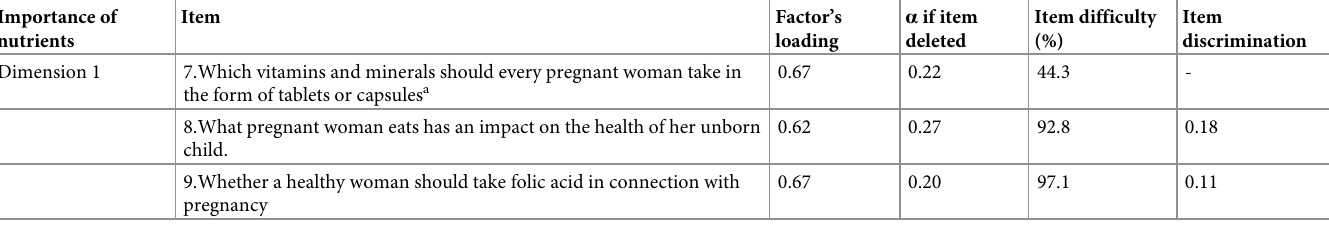
Table 5. Importance of nutrients domain: Factor analysis and reliability analysis results. Importance of nutrients